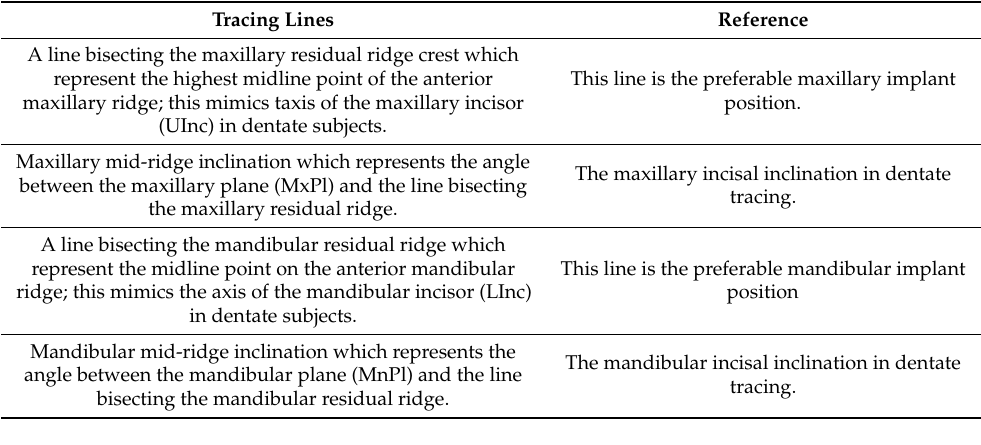
Table 1. Landmarks added by using the lateral cephalometric dentate tracing as guidance.